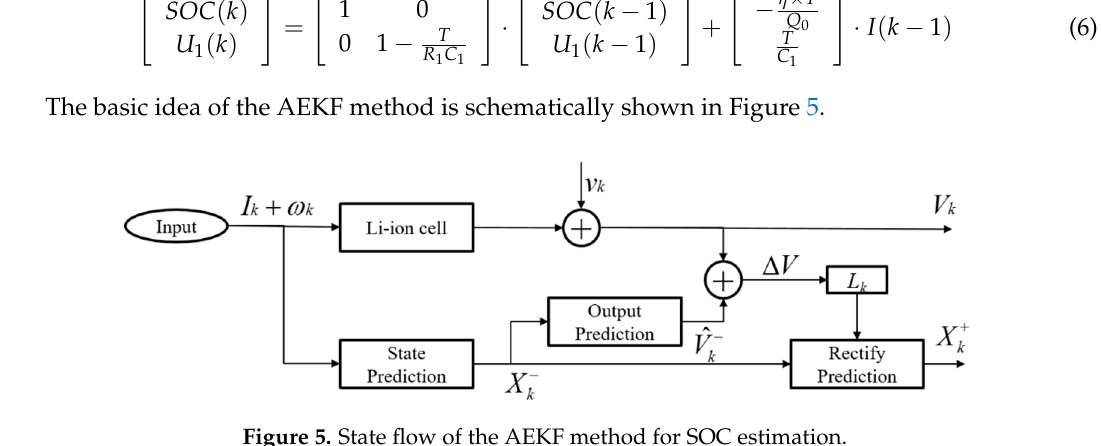
Figure 5. State flow of the AEKF method for SOC estimation.